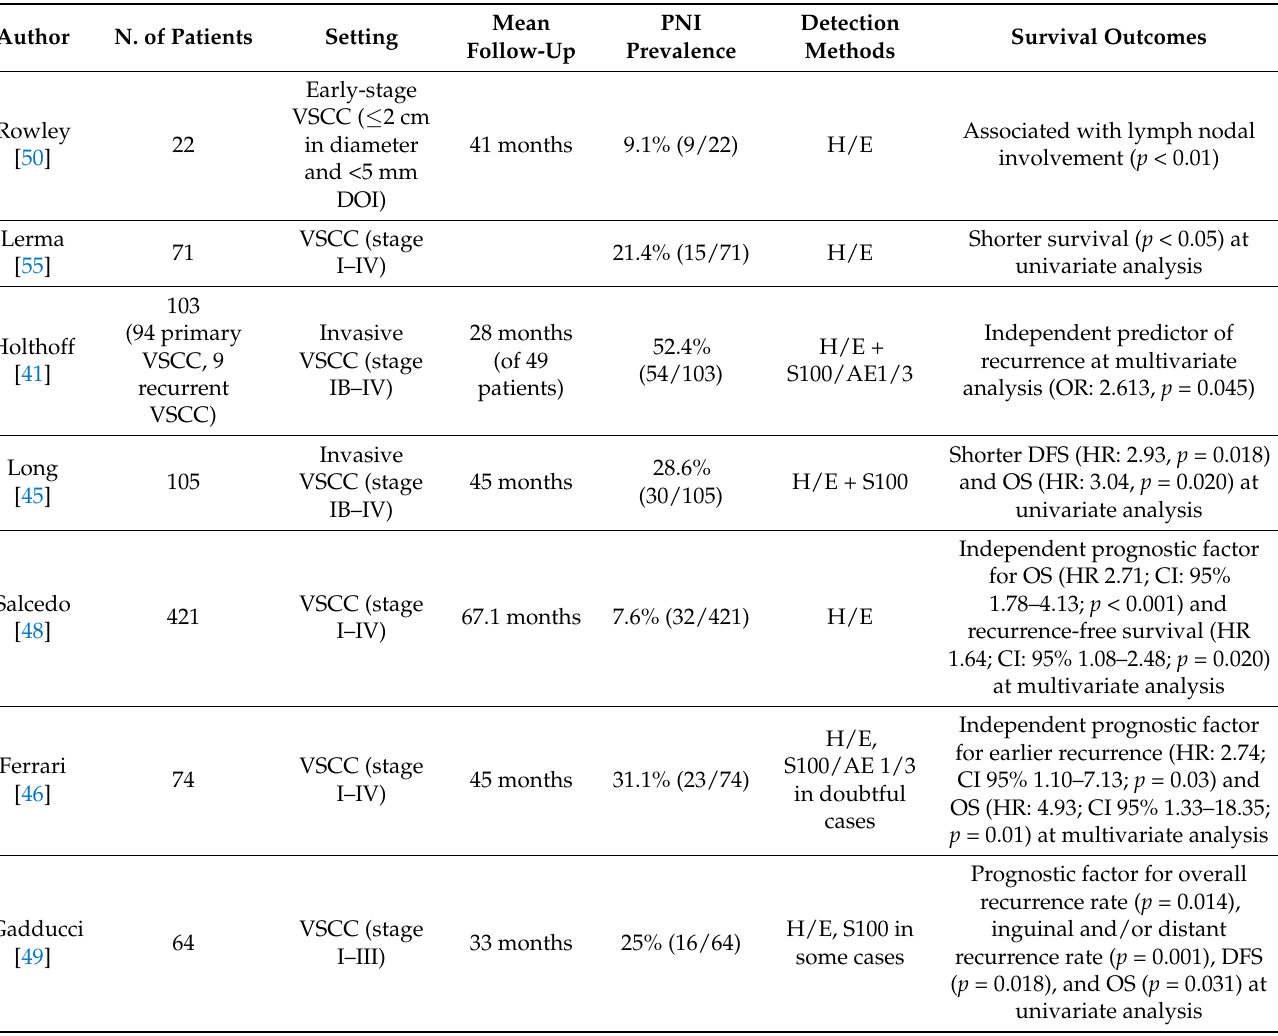
Table 5. Summary of the main studies on the role of PNI in